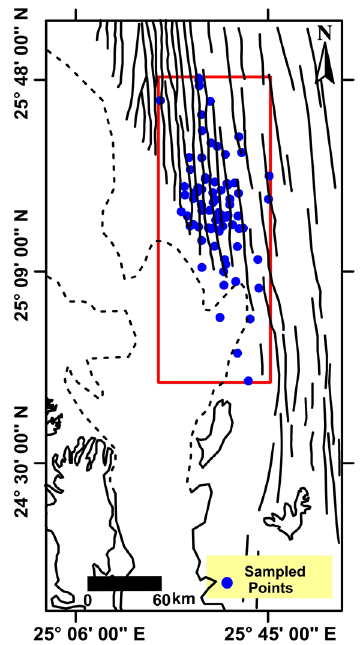
Figure 3. The smallest rectangle enclosing the LDG sampling points has been drawn over the geographic map. The rectangular area (4.17 × 10 3 km 2 ) was employed in the nearest neighbor analysis ( R = 0.87), giving a clustered LDG point pattern.